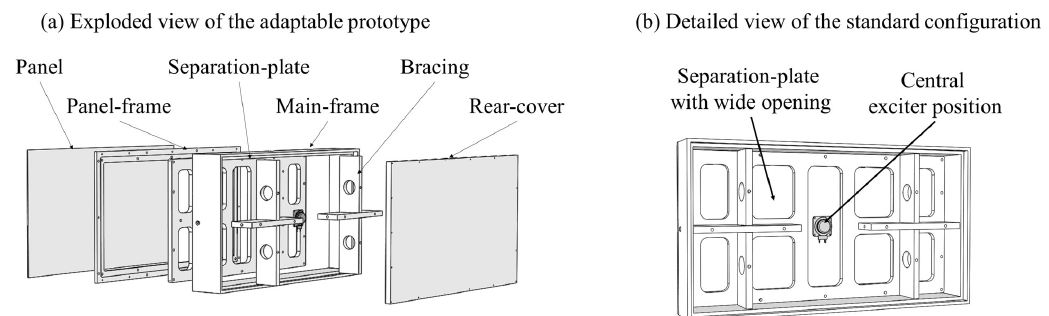
Figure 2. ( a ) Drawing of the adaptable prototype, which allows for an individual configuration of different flat-panel loudspeakers with the same boundary conditions. ( b ) Detailed view of the standard configuration with wide openings in the separation plate to minimize air compliance-related